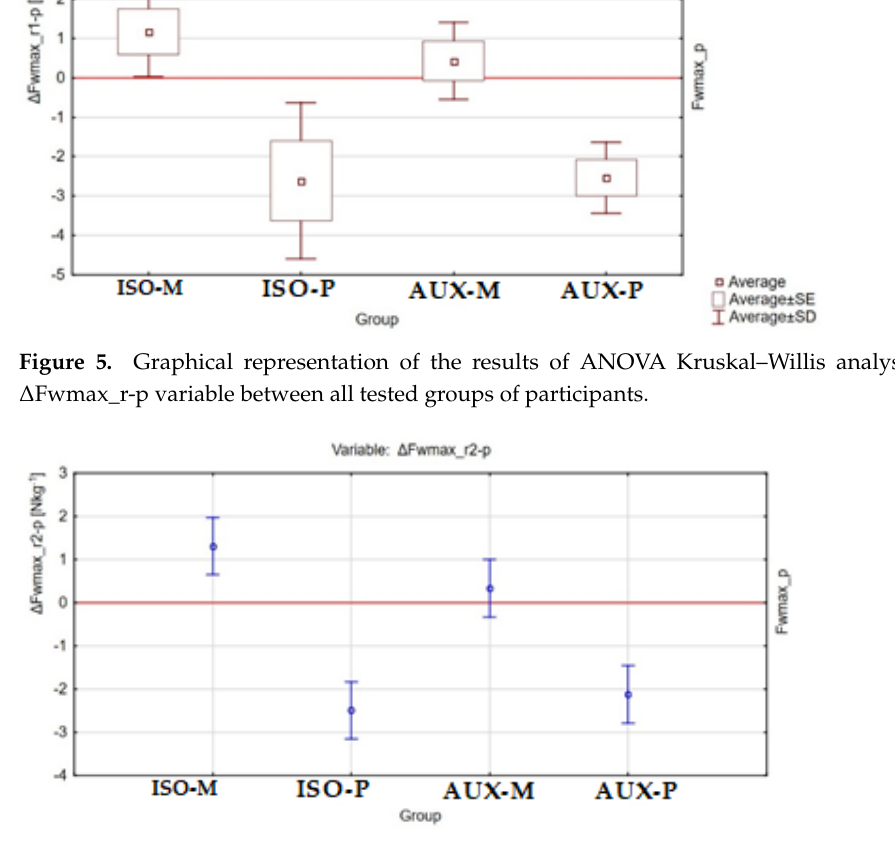
Figure 6. Graphical representation of the results of ANOVA (F- test) for the ΔFwmax_r2 -p variable between all tested groups of participants.